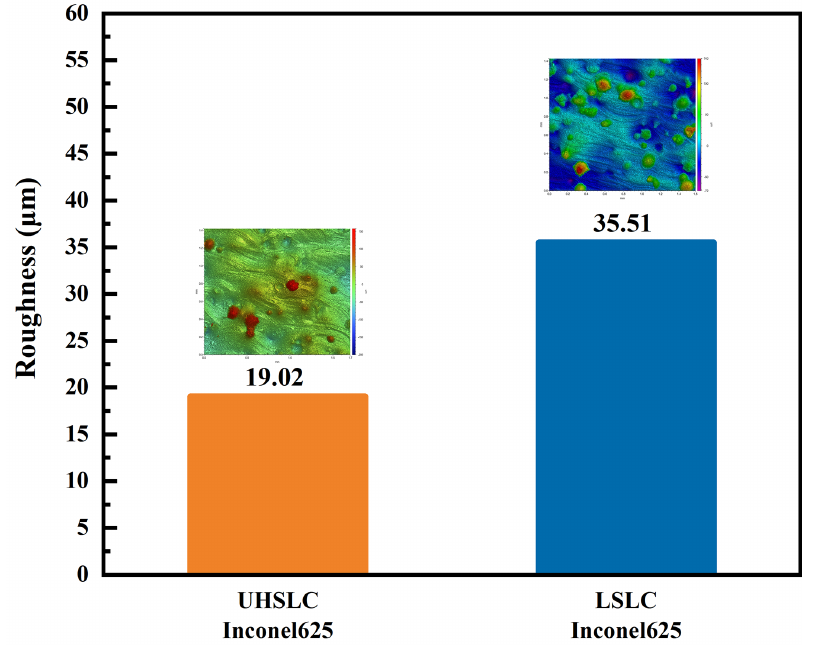
Figure 6. The surface roughness of Inconel625 coatings prepared by UHSLC and LSLC.